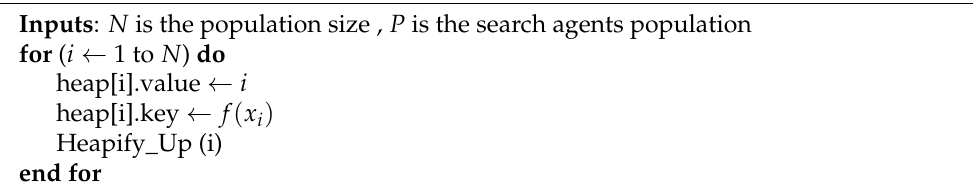
Algorithm 3 Build_Heap (P, N) Pseudo-code